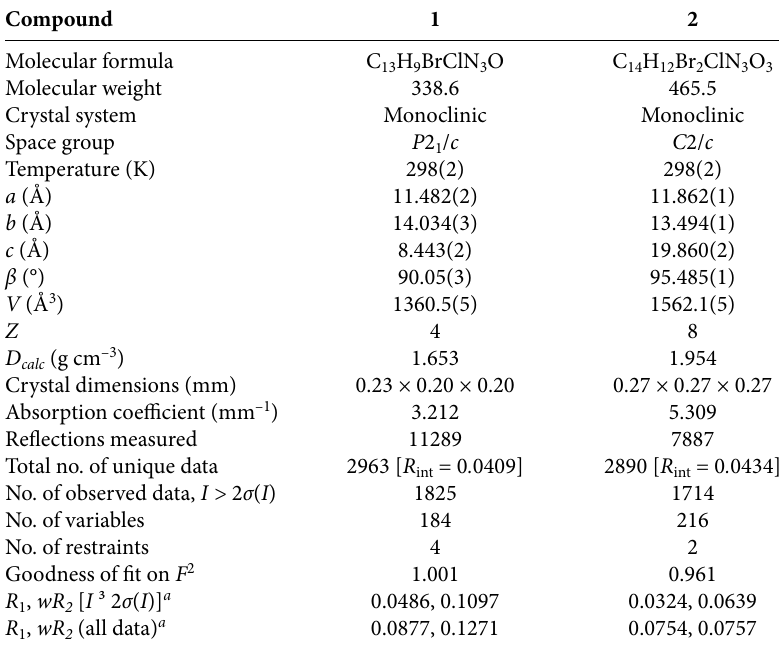
Table 1. Crystal data, data collection and structure refinement for the compounds